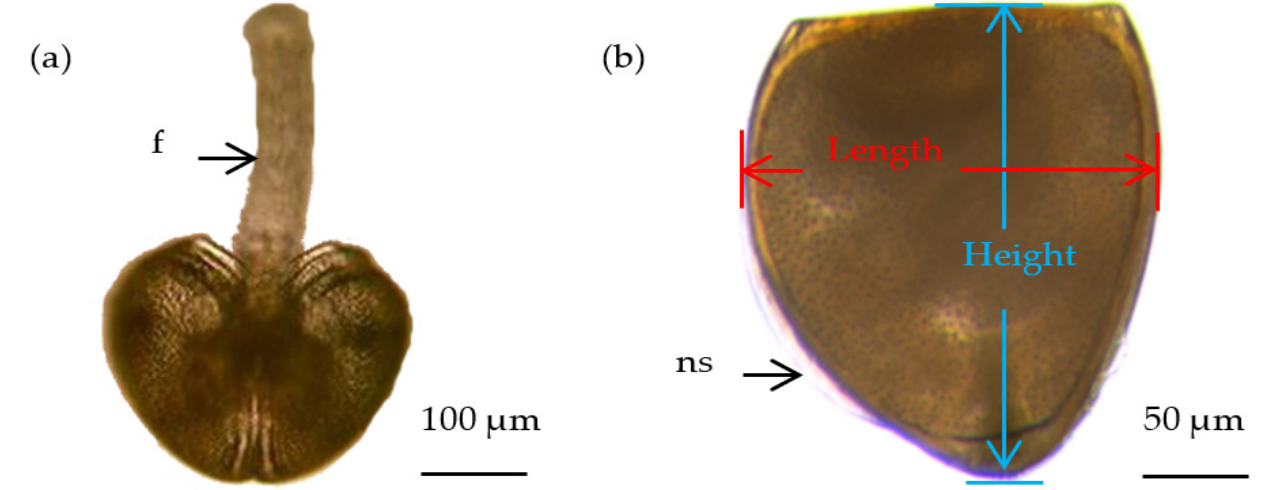
Figure 1. Morphology of freshly transformed juveniles. ( a ) front view; ( b ) side view; f, foot; ns, new shell.